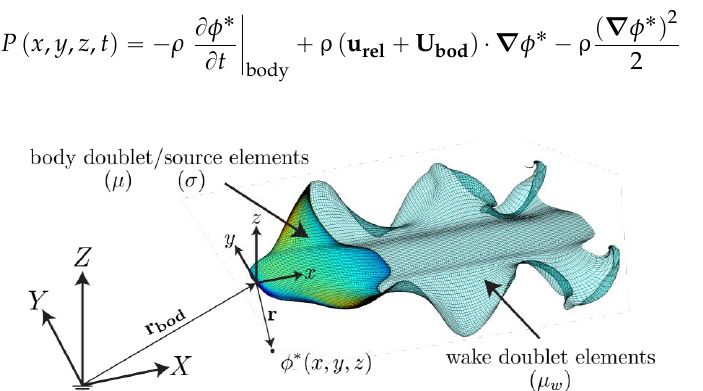
Figure 2. Boundary element method schematic showing the body elements and the wake elements. A body-fixed frame of reference is attached at the leading-edge of a swimmer. The inertial frame of reference is attached to the undisturbed fluid.